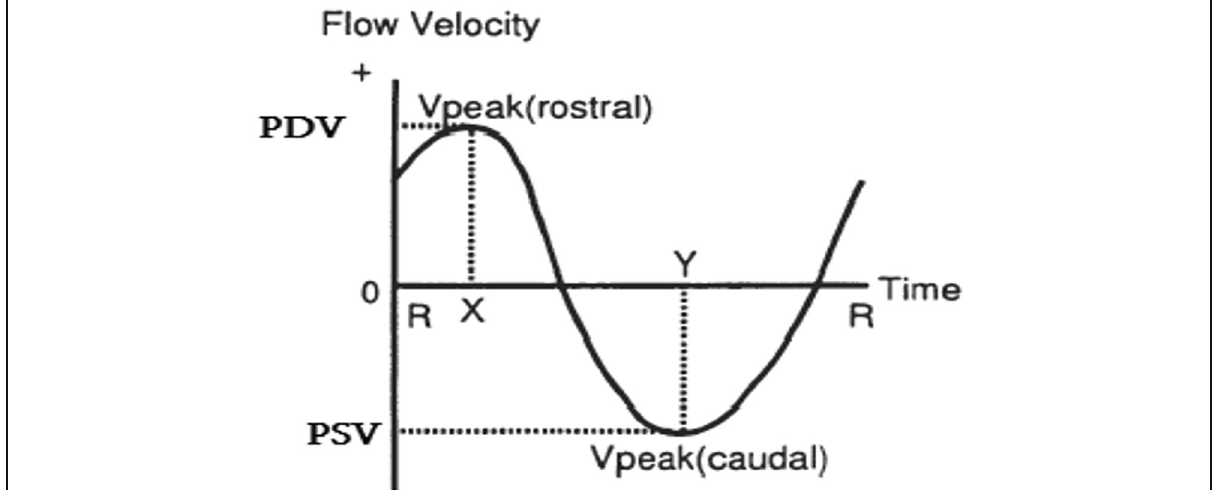
Fig. 2 Schematic drawing of CSF flow velocity show (PSV), (PDV), Vmax = (PSV + PDV)/2